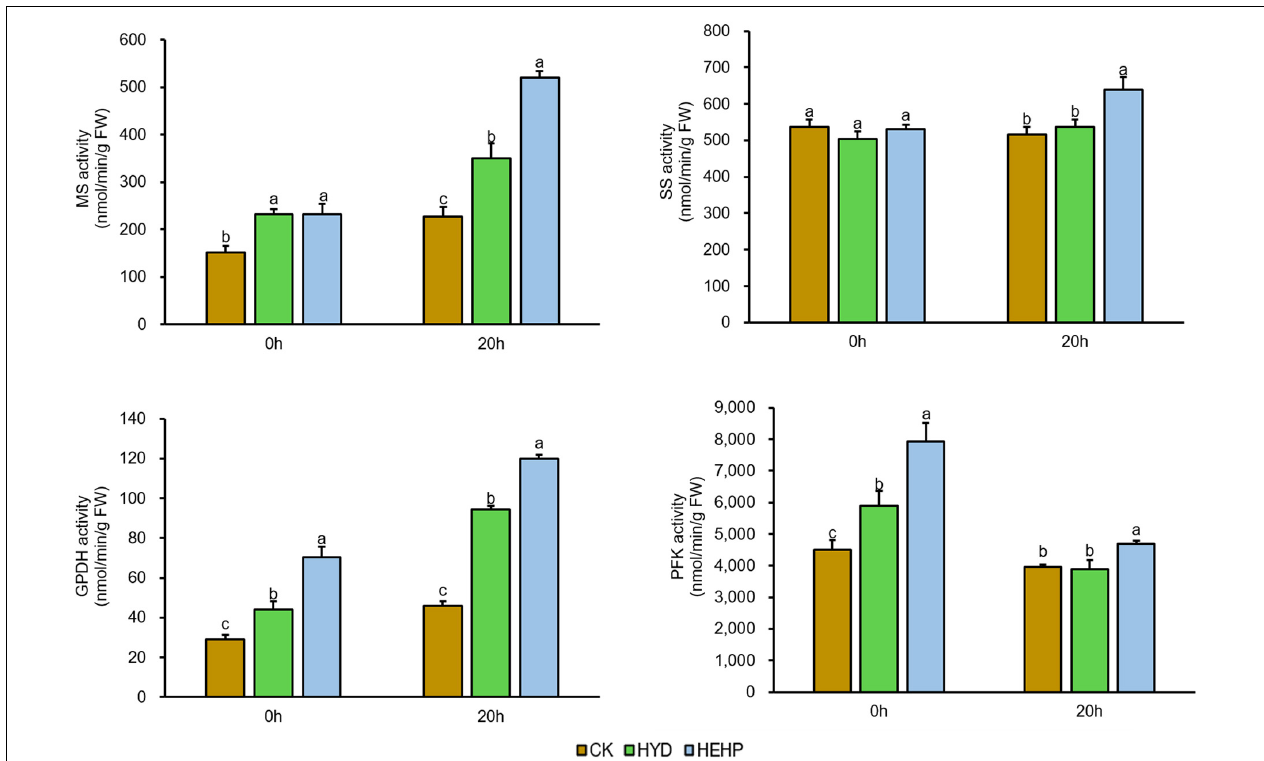
FIGURE 7 | Effects of different treatments on key enzyme activities. MS, malate synthase; SS, sucrose synthase; GPDH, glucose-6-phosphatedehydrogenase; PFK, 6-phosphofructokinase. Values represent the means ± SE from six biological replications. The different lowercase letters above the bars indicate significant differences in 95% probability level ( p < 0.05, Duncan test was performed after ANOVA